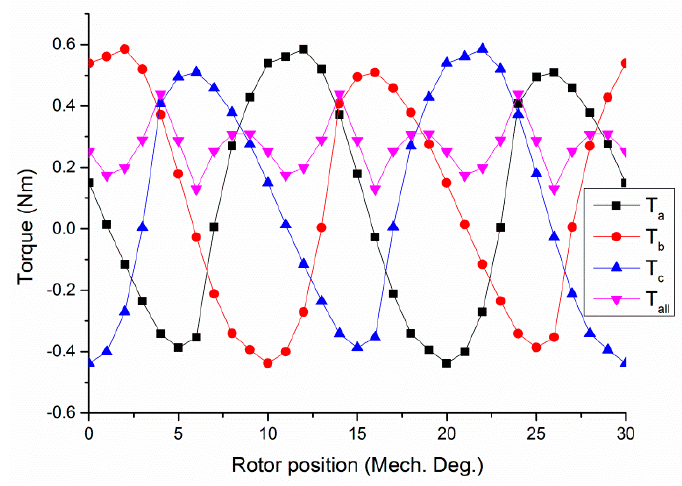
Figure 8. EM torque of FRCPM.